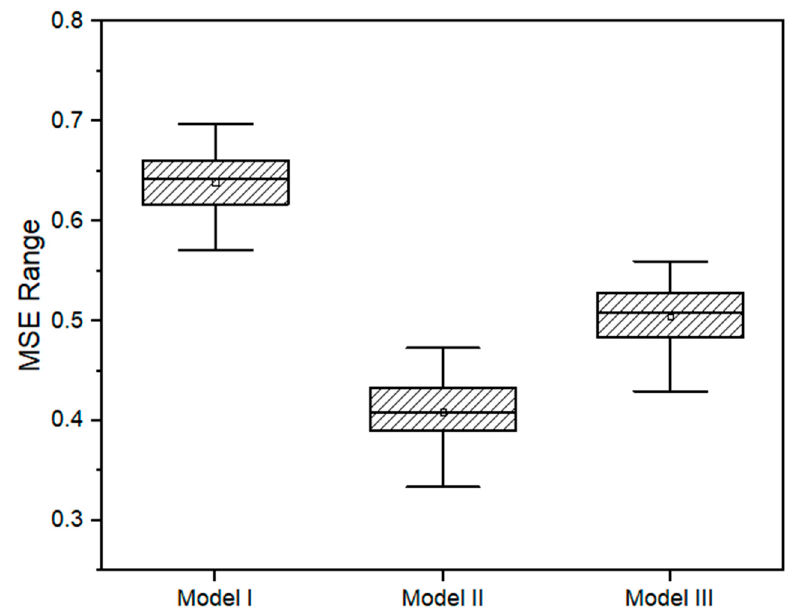
Figure 8. Boxplot indicating the MSE range from the training of the best ANN structure for each model. Vertical bars indicate the 1st and 4th quartiles. The dot inside the box indicates the mean value, and the horizontal bar indicates the median value.